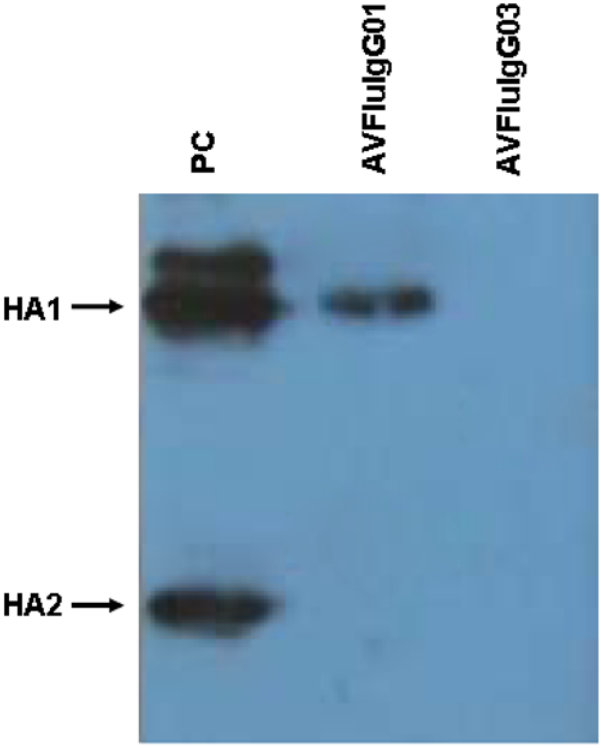
Figure 3. Western Blot analysis of AVFluIgG01 and AV- FluIgG03. Purified AH/1/05 virus was applied to SDS–PAGE. The antigens were probed with either AVFluIgG01 or AVFluIgG03. A human serum from H5N1 virus-infected patient was used as a positive control (PC).